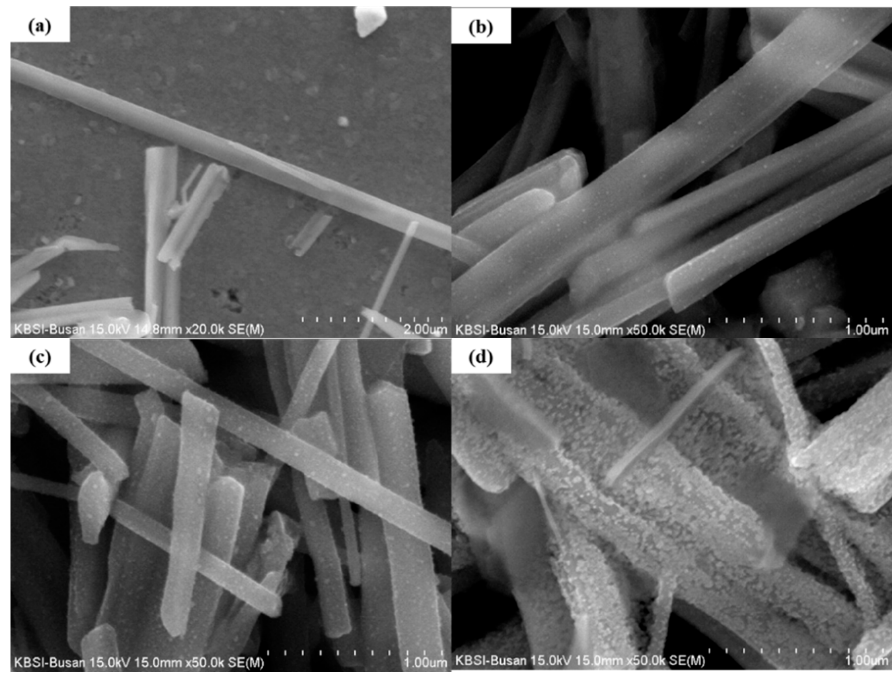
Figure 1. FE-SEM image of ( a ) pristine CuO, ( b ) CuO NWs decorated with 0.025 M ZnO NPs, ( c ) CuO NWs decorated with 0.05 M ZnO NPs, and ( d ) CuO NWs decorated with 0.075 M ZnO NPs.